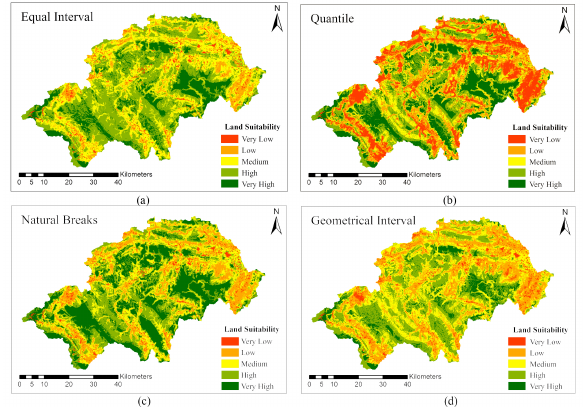
Figure 2. The 5-class land suitability maps of Shennongjia